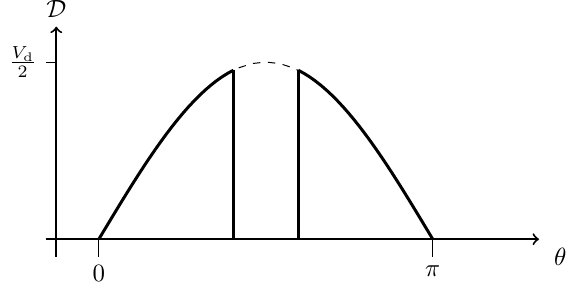
Figure 9: Impulse response as function of the input, η m = 0 . 7, with sequential partial stroke.